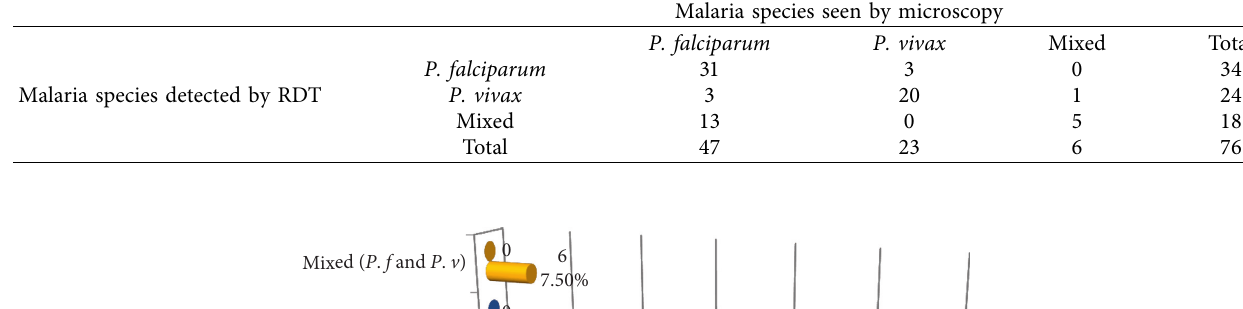
Malaria species seen by microscopy